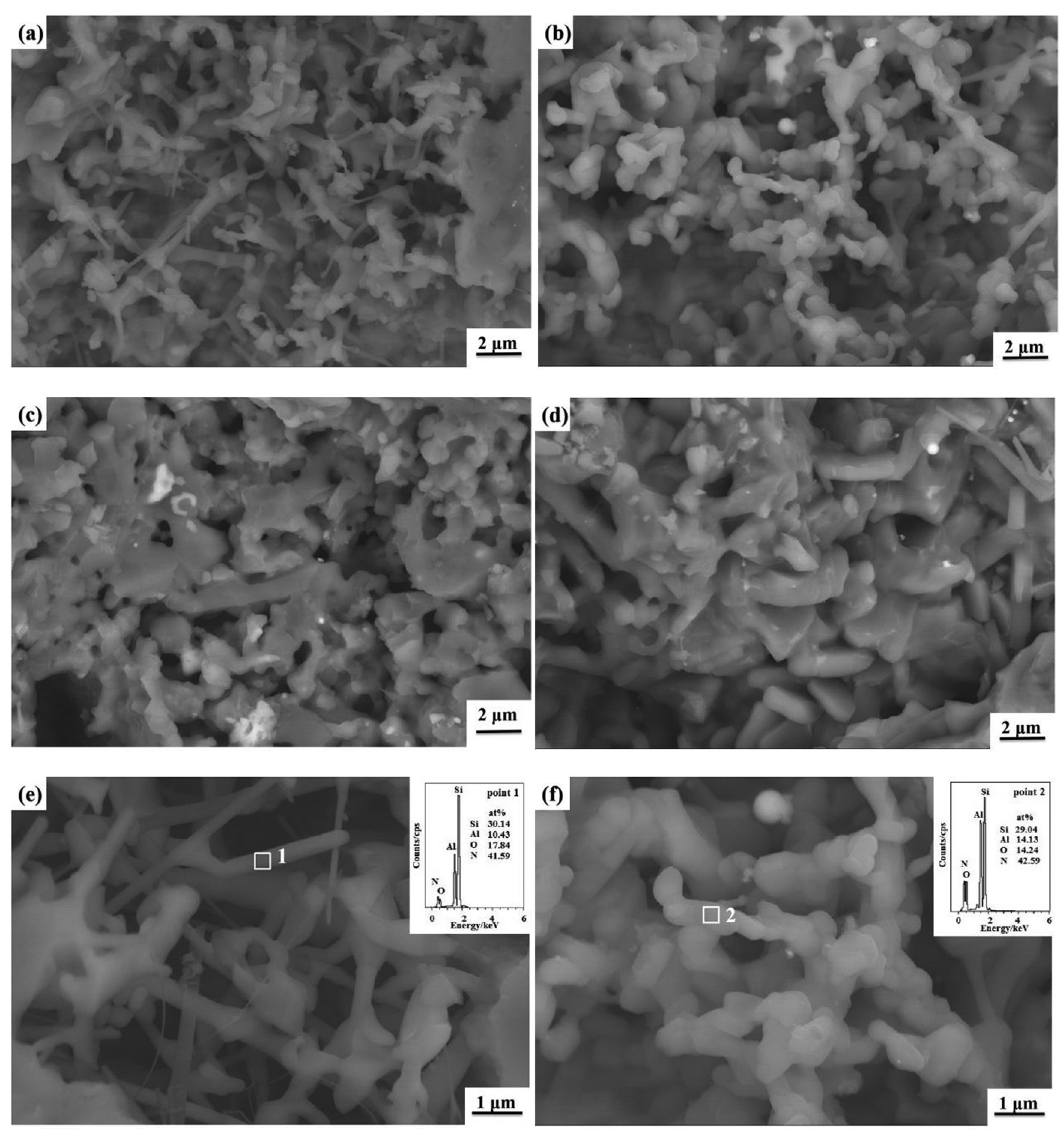
Figure 4: The SEM photographs of β - SiAlON ceramics: ( a ) 1 # , ( b ) 2 # , ( c ) 3 # , ( d ) 4 # , and ( e ) and ( f ) the enlarged morphology and EDS analysis of 1 # and 2 #